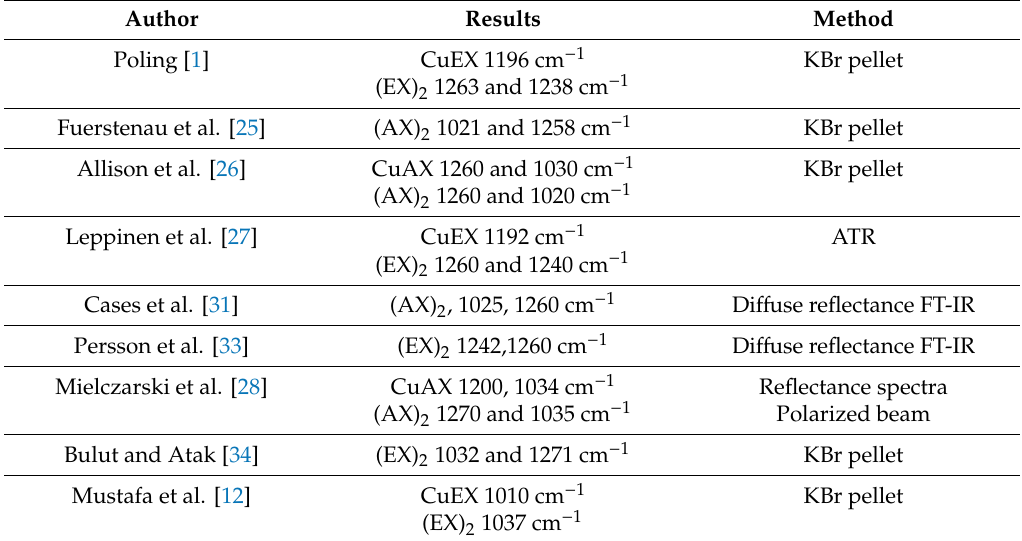
Table 4. IR results of xanthate adsorption product on sulfides surface in